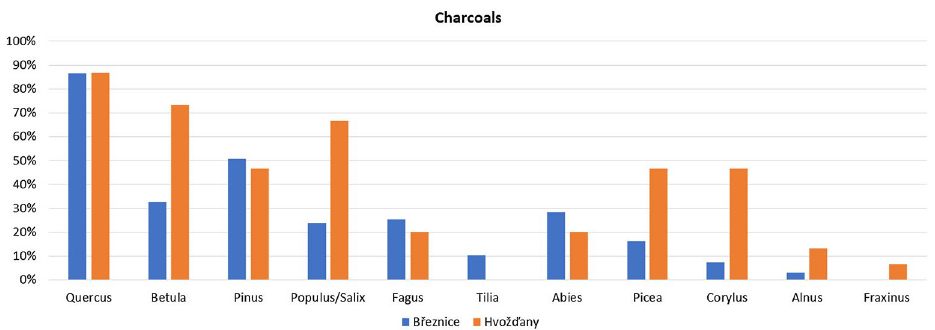
Figure 5. Březnice and Hvožďany. Distribution of charcoals in